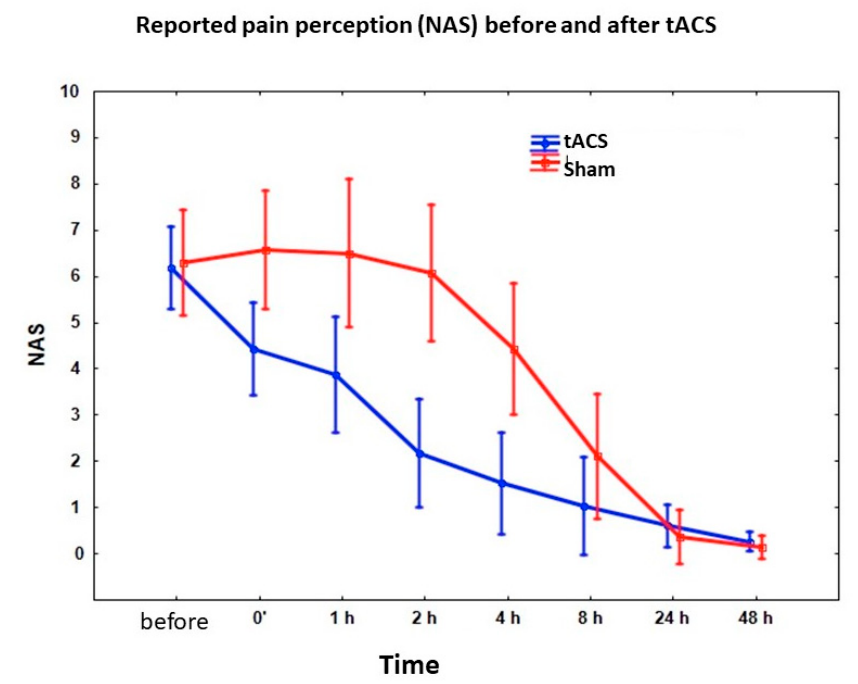
Figure 2. Effect of 140 Hz 0.4 mA tACS applied over the visual cortex on pain severity during migraine attack. X axis represents numerical analogue scale (NAS) values before and after stimulations. Bars represent 95% confidence intervals.